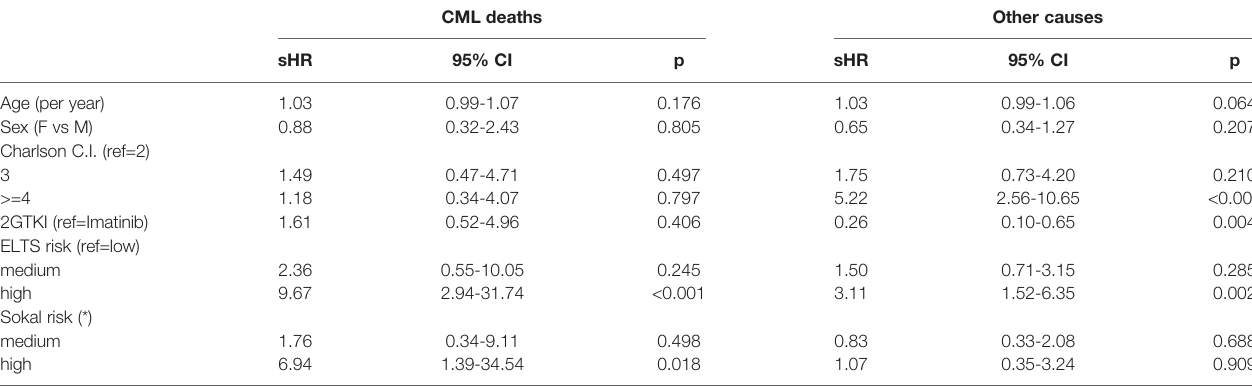
TABLE 4 | Role of prognostic variables and front-line treatments on survival of CML patients by cause of death (CML related or